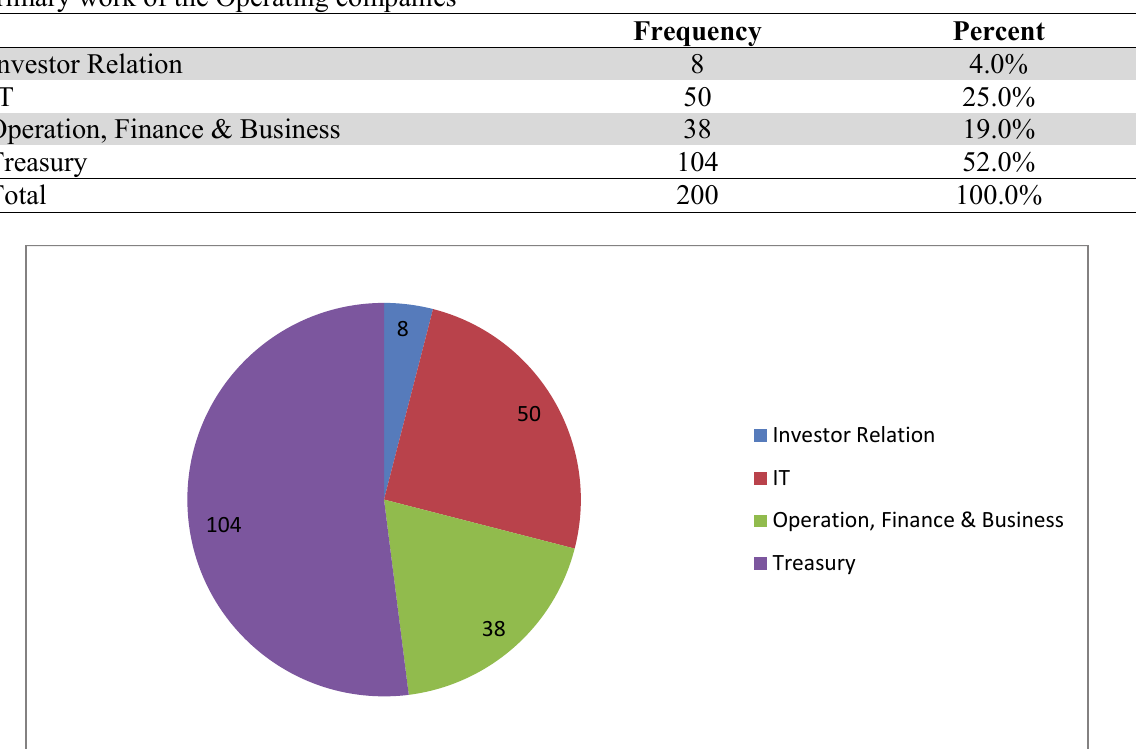
Fig. 1. Primary work of the Operating companies